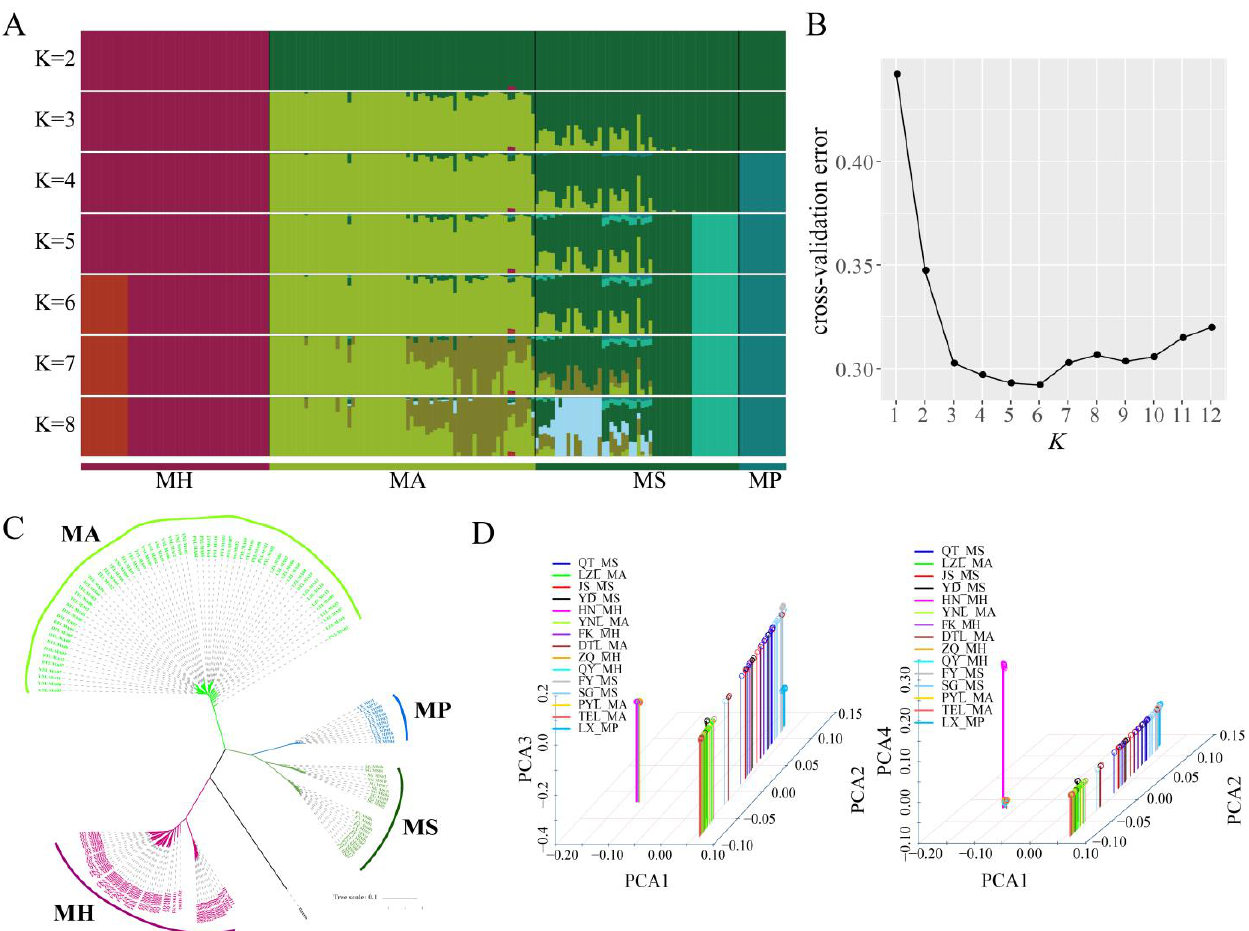
Figure 2. Phylogenetic analysis of different Megalobrama geographical populations. ( A ) Population genetic structure of 180 Megalobrama fish. The length of each colored segment represents the proportion of the individual genome inferred from ancestral populations ( K = 2 – 8). The species name is at the bottom. ( B ) Cross-validation (CV) error for varying values of K in the admixture analysis. The minimum of estimated CV error on K = 6 suggests the most suitable number of ancestral populations. ( C ) Maximum-likelihood-based phylogenetic tree constructed using no admixed individuals. The scale bar represents pairwise distances between different individuals. Different colors represent different Megalobrama species. ( D ) Principal component analysis (PCA) of Megalobrama populations. Eigenvector 1, 2, 3, and 4 explained 45.06%, 18.03%, 4.00%, and 1.73% of the total variance, respectively. MH refers to M. hoffmanni , MA to M. amblycephala , MS to M. skolkovii , MP to M. pellegrini .